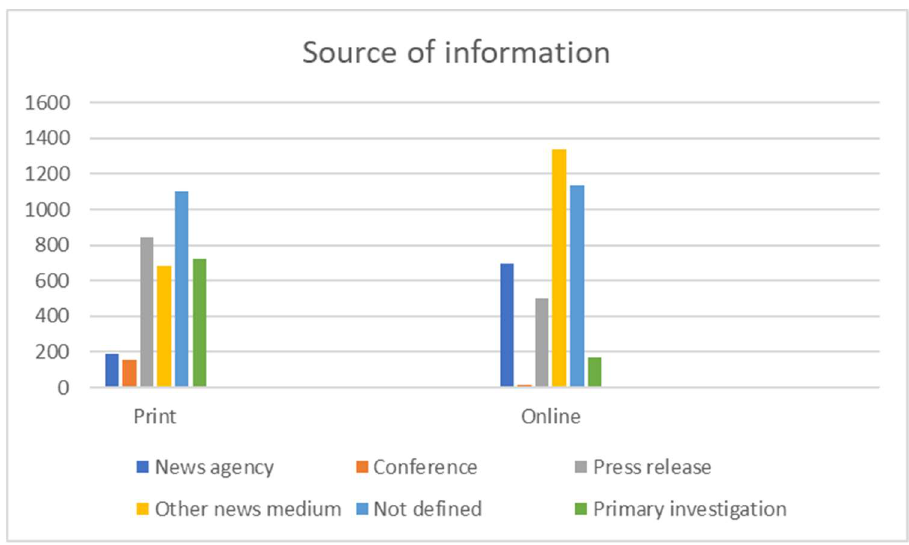
Figure 4. Source of